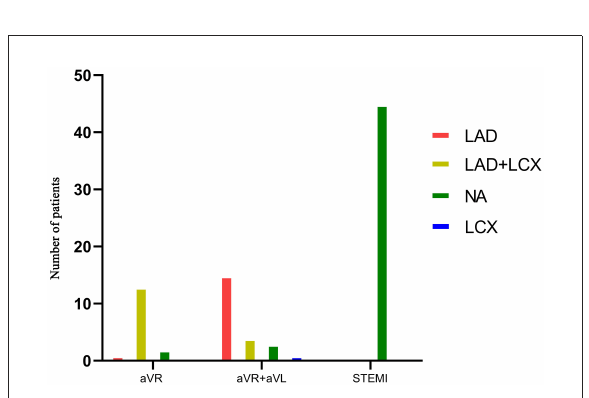
FIGURE4 Relationship between collateral filling territories and the three main ECG patterns in LM occlusion group.